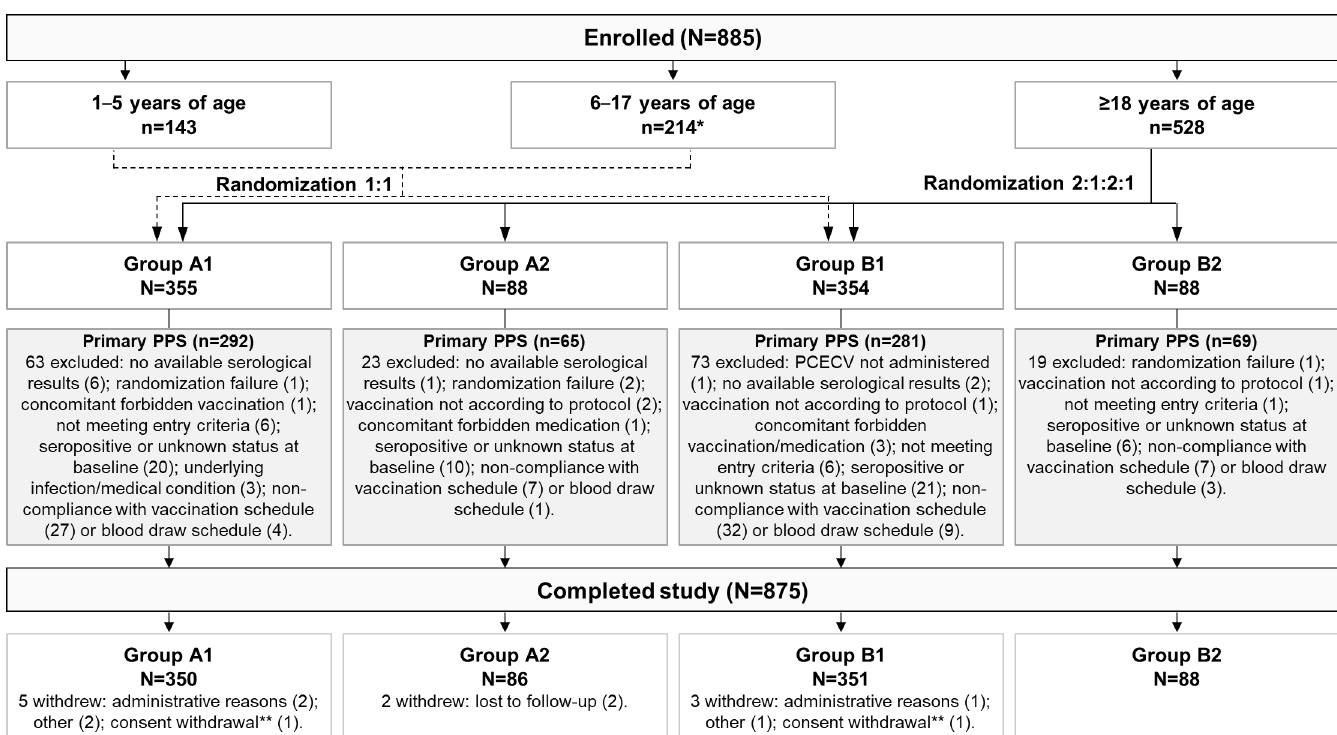
Fig 1. Participant flow diagram. Group A1, participants receiving PCECV according to the 4-site/1-week ID regimen; Group A2, participants receiving PCECV according to the 4-site/1-week ID regimen and HRIG at first visit; Group B1, participants receiving PCECV according to the 2-site/TRC regimen; Group B2, participants receiving PCECV according to the 2-site/TRC regimen and HRIG at first visit; PCECV, purified chick embryo cell culture vaccine; ID, intradermal; HRIG, human rabies immunoglobulin; TRC, Thai Red Cross; n, number of participants in each age stratum; N, number of participants in each group; PPS, per-protocol set. (cid:3) One 11-year- old participant was erroneously randomized in Group B2. (cid:3)(cid:3) Not due to an adverse event.